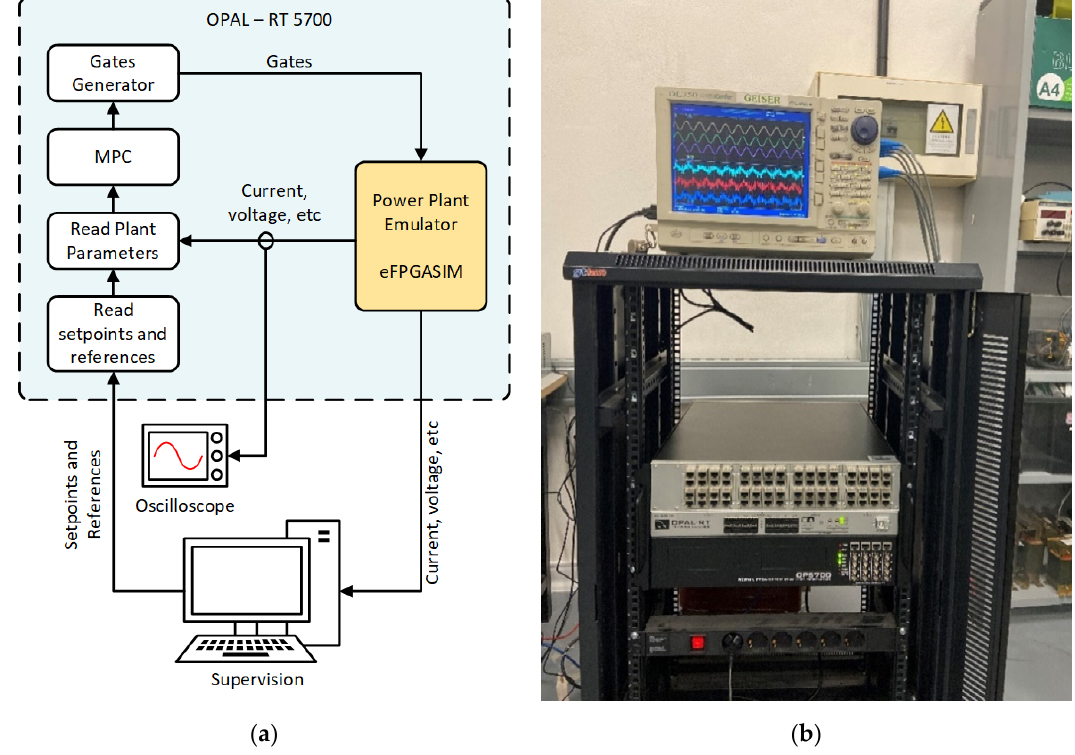
Figure 7. Hardware-in-the-loop implementation: ( a ) OPAL-RT 5700 Flowchart; ( b ) Implementation image with emphasis on signals in the oscilloscope.